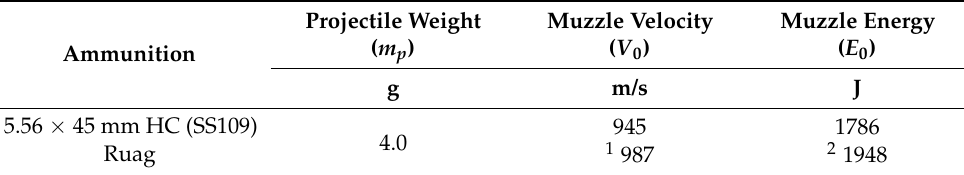
Figure 2. 5.56 × 45 mm HC (SS109) ammunition used in the research: ( a ) cross-section [22], ( b ) whole bullet, ( c ) cartridge [18]. Table 1. Technical data of ammunition used in the experiment [23].